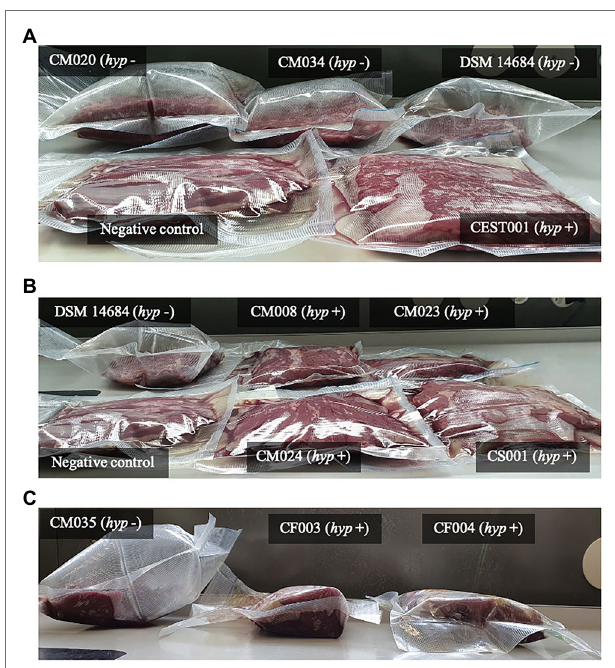
FIGURE 8 | Gas production in vacuum-packed beef at 8 ° C by C. estertheticum and C. tagluense with ( hyp +) or without ( hyp − ) hyp hydrogenase gene cluster. (A) The hyp − C. estertheticum CM020, CM034, and DSM 14864 caused pack distention while the hyp + C. estertheticum CEST001 only caused loss of vacuum. (B) The hyp + C. tagluense CM008, CM023, CM024, and CS002 caused loss of vacuum. Clostridium estertheticum DSM 14864 ( hyp − ) was the positive control. (C) The hyp + C. estertheticum CF003 and CF004 did not cause pack distention even after 56 days of incubation compared to the hyp − C. estertheticum CM035. In (A) and (B) , the samples were incubated for 28